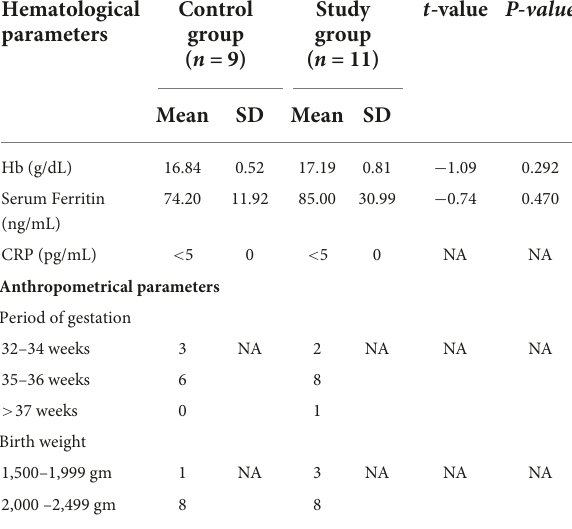
tryptophane hydroxylase (serotonin) and tyrosine hydroxylase (norepinephrine); both help in mood elevation (18). Iron